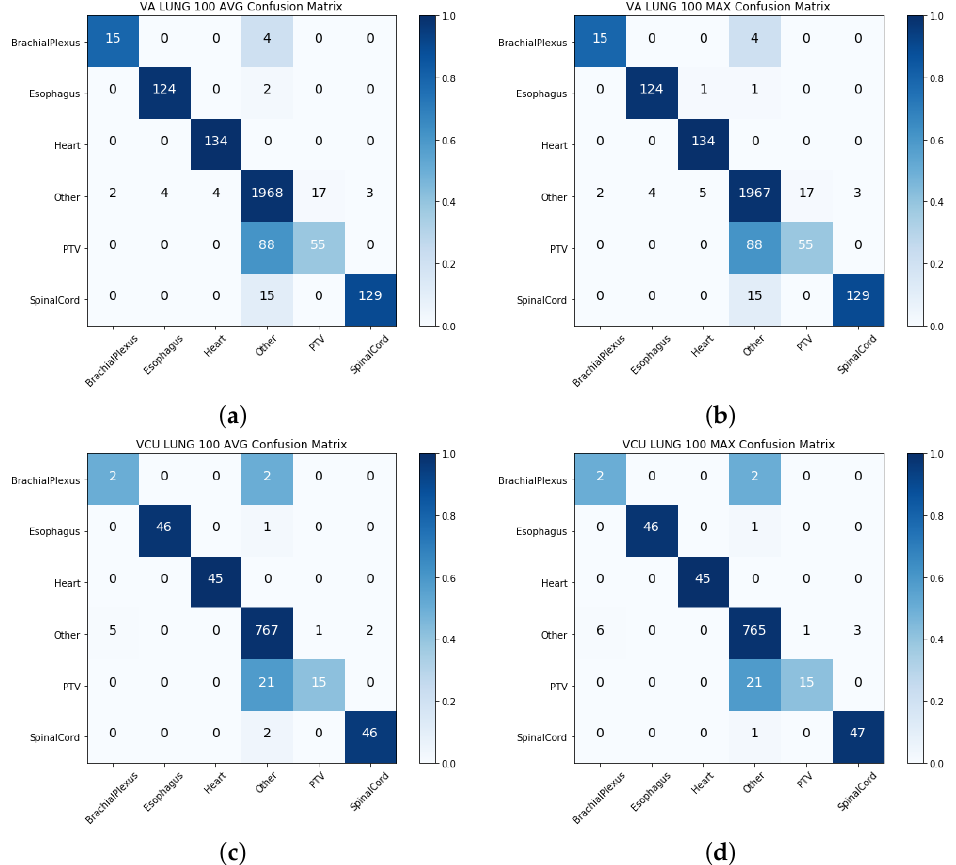
Figure 6. Late integration: confusion matrix for VA-ROQS and VCU lung datasets: ( a ) VA-ROQS lung AVG integration, ( b ) VA-ROQS lung MAX integration, ( c ) VCU lung AVG integration, and ( d ) VCU lung MAX integration. A darker color demonstrates more accurate prediction, and the diagonal shows the labels predicted correctly.